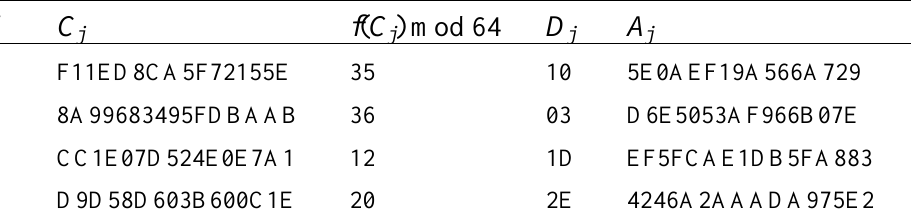
Table 2. Decryption of C2 using